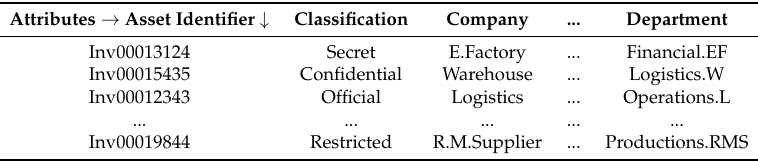
Table 2. List of Critical Group